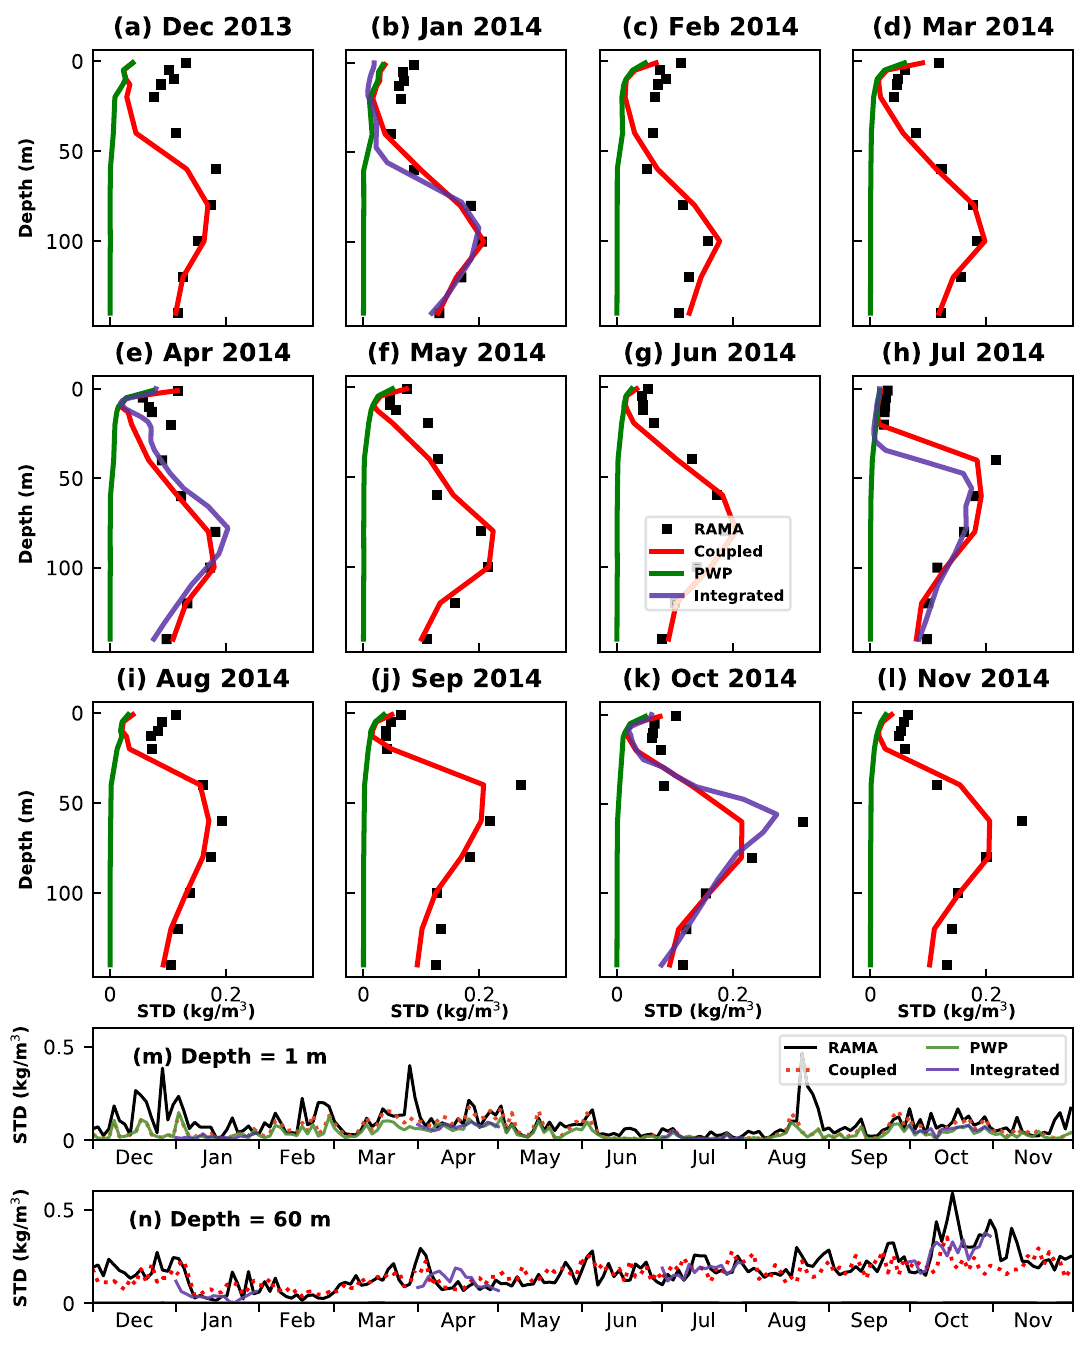
Figure 2. ( a – l ) Comparison of monthly-averaged daily standard deviation profiles of density between RAMA observations (black), Coupled model (red), PWP model (green), and Integrated model (blue). Time-series of daily standard deviation at ( m ) 1 m and ( n ) 60 m